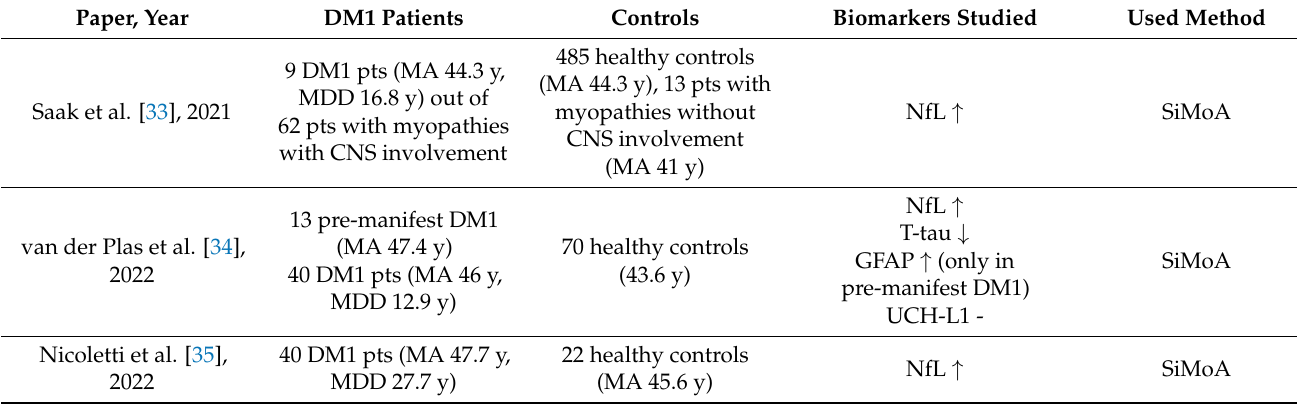
Table 2. Research studies concerning blood-based biomarkers of neurodegeneration in DM1.